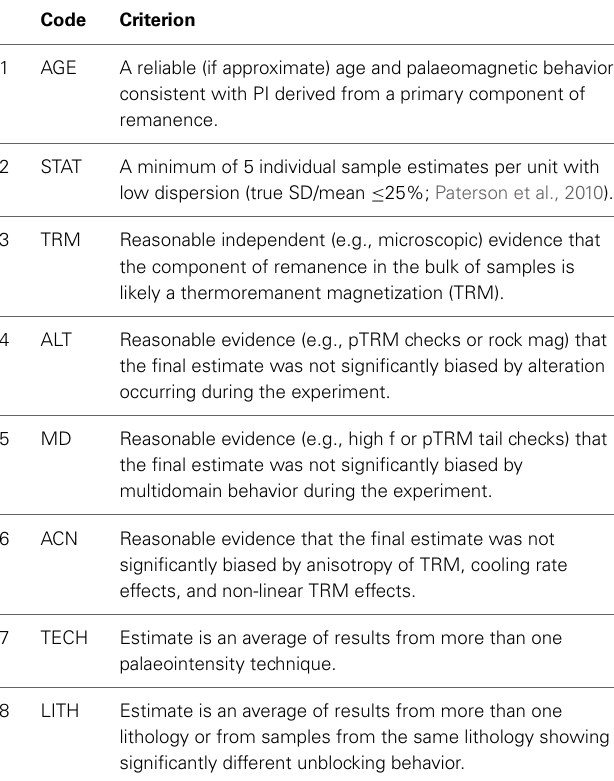
Table 1 | Summary of proposed Q PI